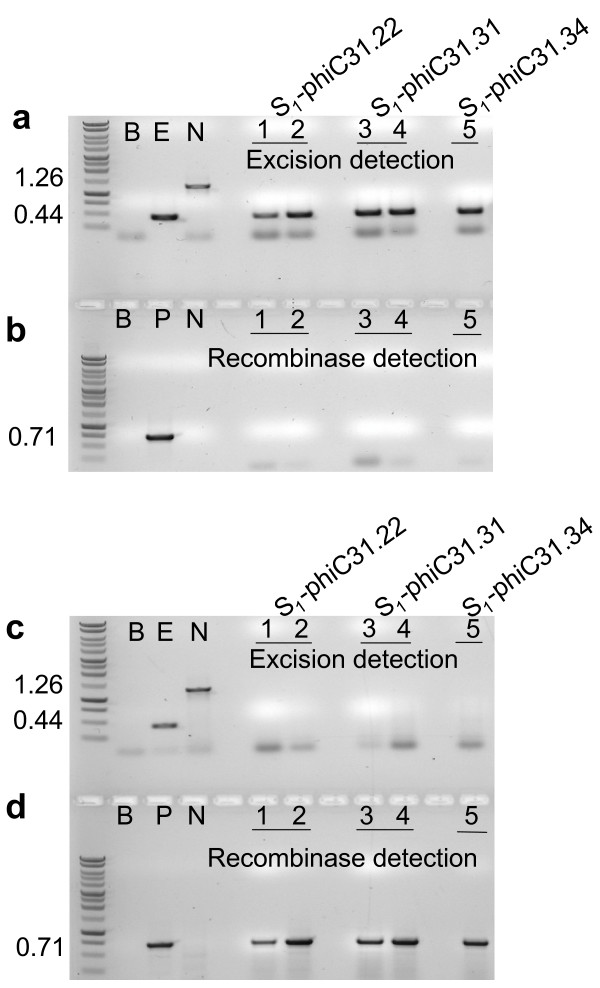
PCR analysis for site-specific recombination and the presence of the phiC31 gene in the S1 generation. PCR reactions (a, c) with primers e and f (Fig. 1) or (b, d) with primers g and h (Fig. 1) on representative plant DNAs. a, b) (lanes 1, 2) Self fertilized -Excision only target lines S1-phiC31. 22.3.18.1, 22.29.7.1; (lanes 3, 4) S1-phiC31.31.1.1, 31.31.13.1; (lane 5) S1-phiC31.34.2.10.1. c, d) Self fertilized - Recombinase only expression lines (lanes 1, 2) S1-phiC31.22.3.5.1, 22.15.5.1; (lanes 3, 4) S1-phiC31.31.23.10.1, 31.31.36.2; (lane 5) S1-phiC31.34.9.2.1. Control lanes are B (blank, no DNA); E (excision, pN3-phiC31exc); N (no excision, pN3-phiC31); P (recombinase, pCOXS3-phiC31).